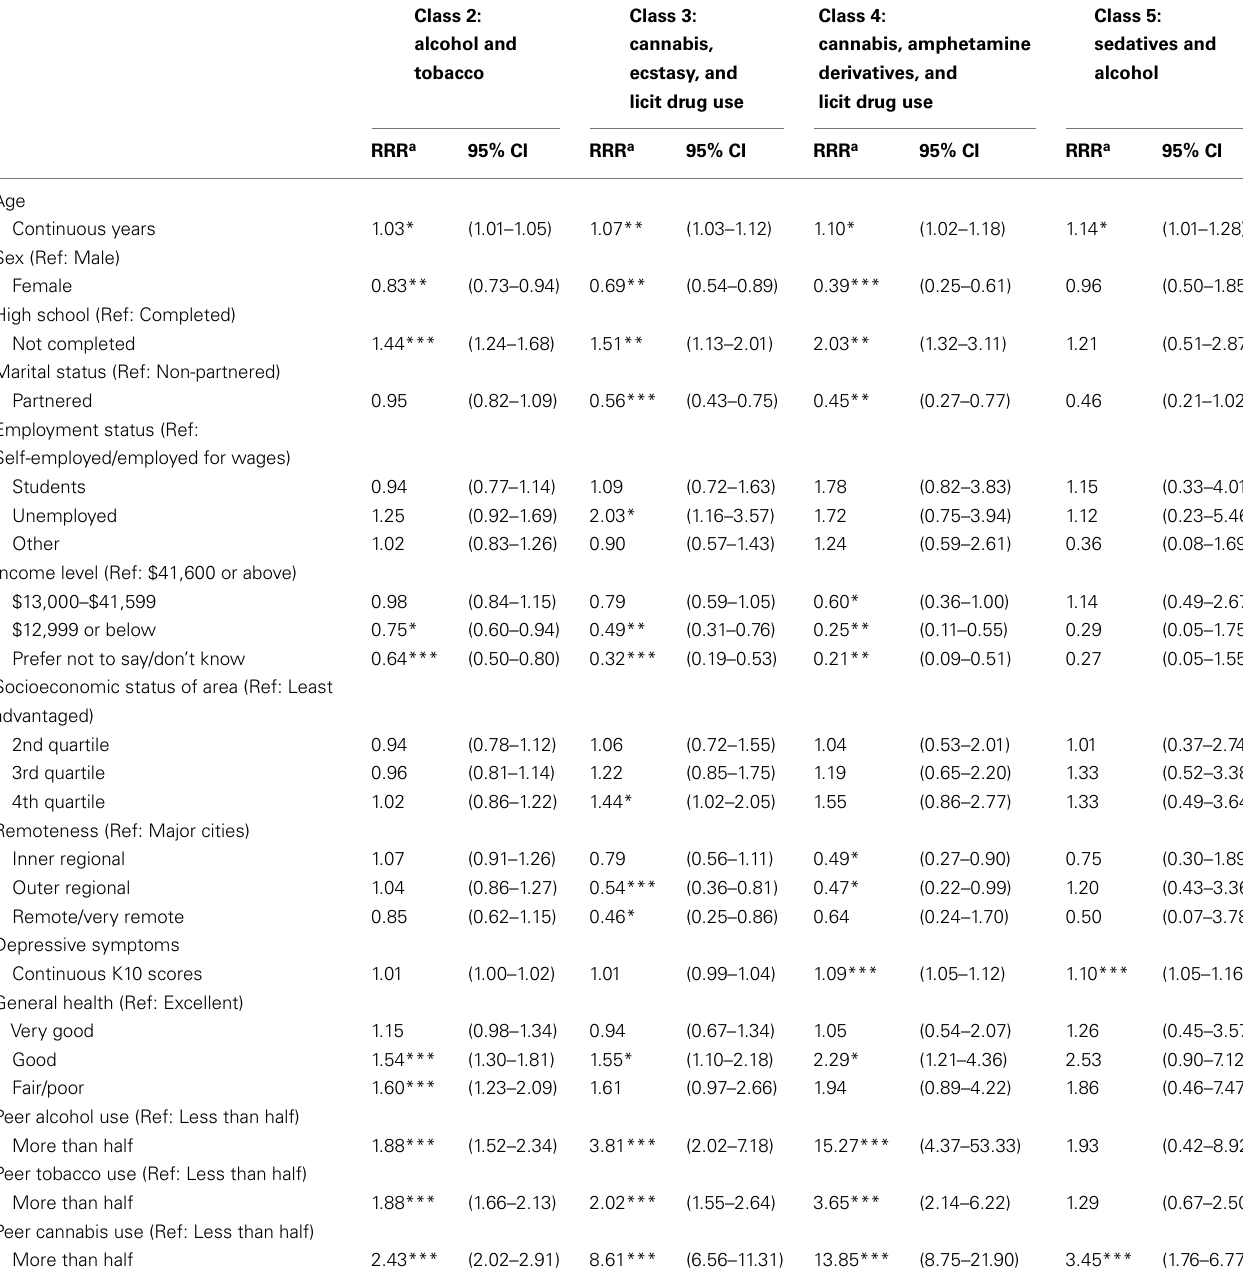
Table 2 | Relative risk ratio estimates and 95% confidence intervals from the multinomial logistic regression with theAlcohol class as the reference group